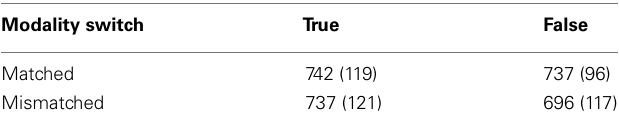
Table 3 |Average reaction time (ms) and standard deviation for the true/false judgments on target